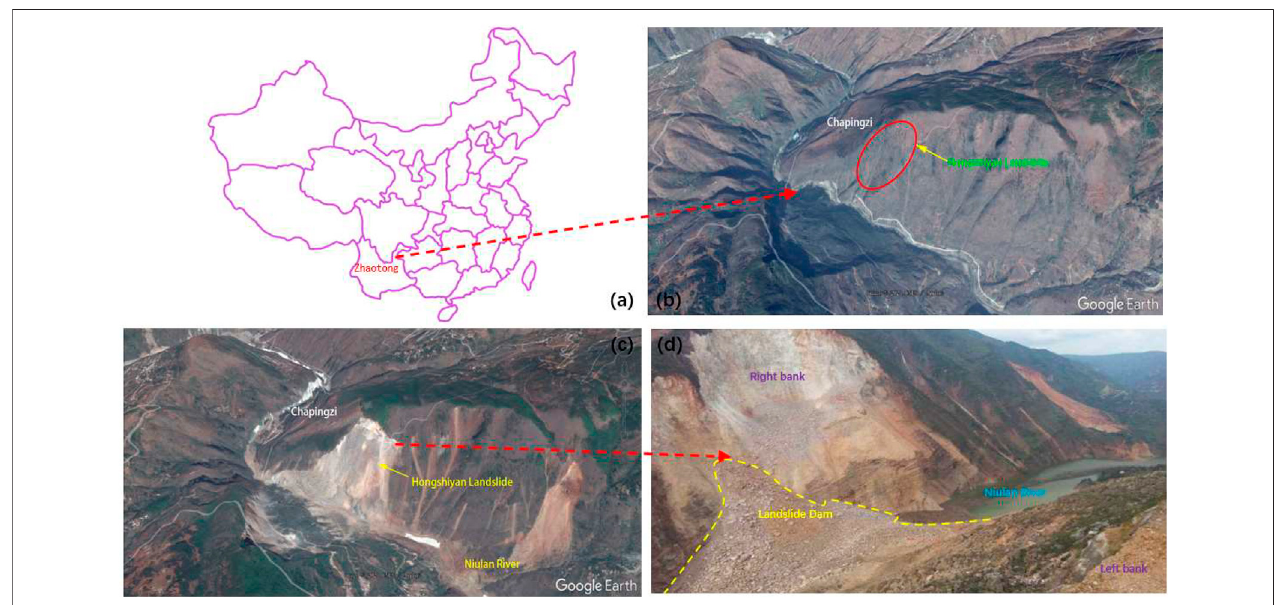
FIGURE2|(A) LocationoftheHongshiyan landslide; (B) remotesensingimage beforetheHongshiyanlandslide(modi fi edfromGoogleEarth); (C) remotesensing image after the Hongshiyan landslide (modi fi ed from Google Earth); (D) landslide dam (modi fi ed from